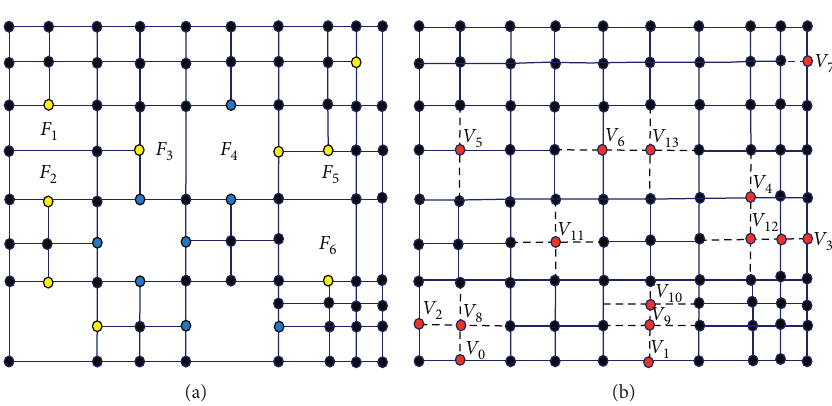
Figure 1: Full-extension T-mesh. (a) T-mesh; (b) full-extension T-mesh T